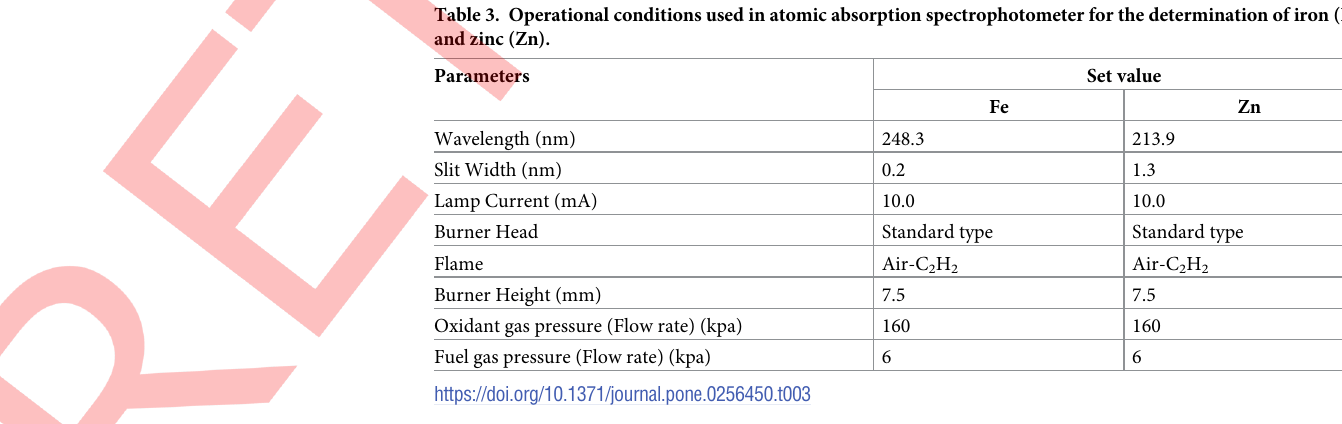
Table 3. Operational conditions used in atomic absorption spectrophotometer for the determination of iron (Fe) and zinc